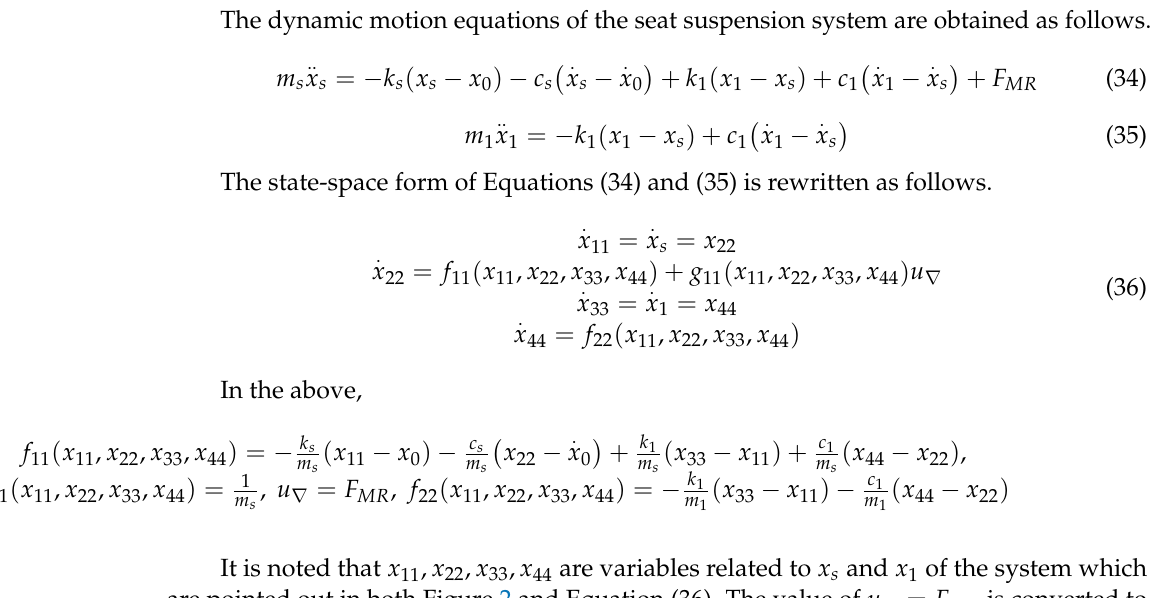
Figure 2. Mechanical model of the vehicle seat suspension with magnetorheological (MR)